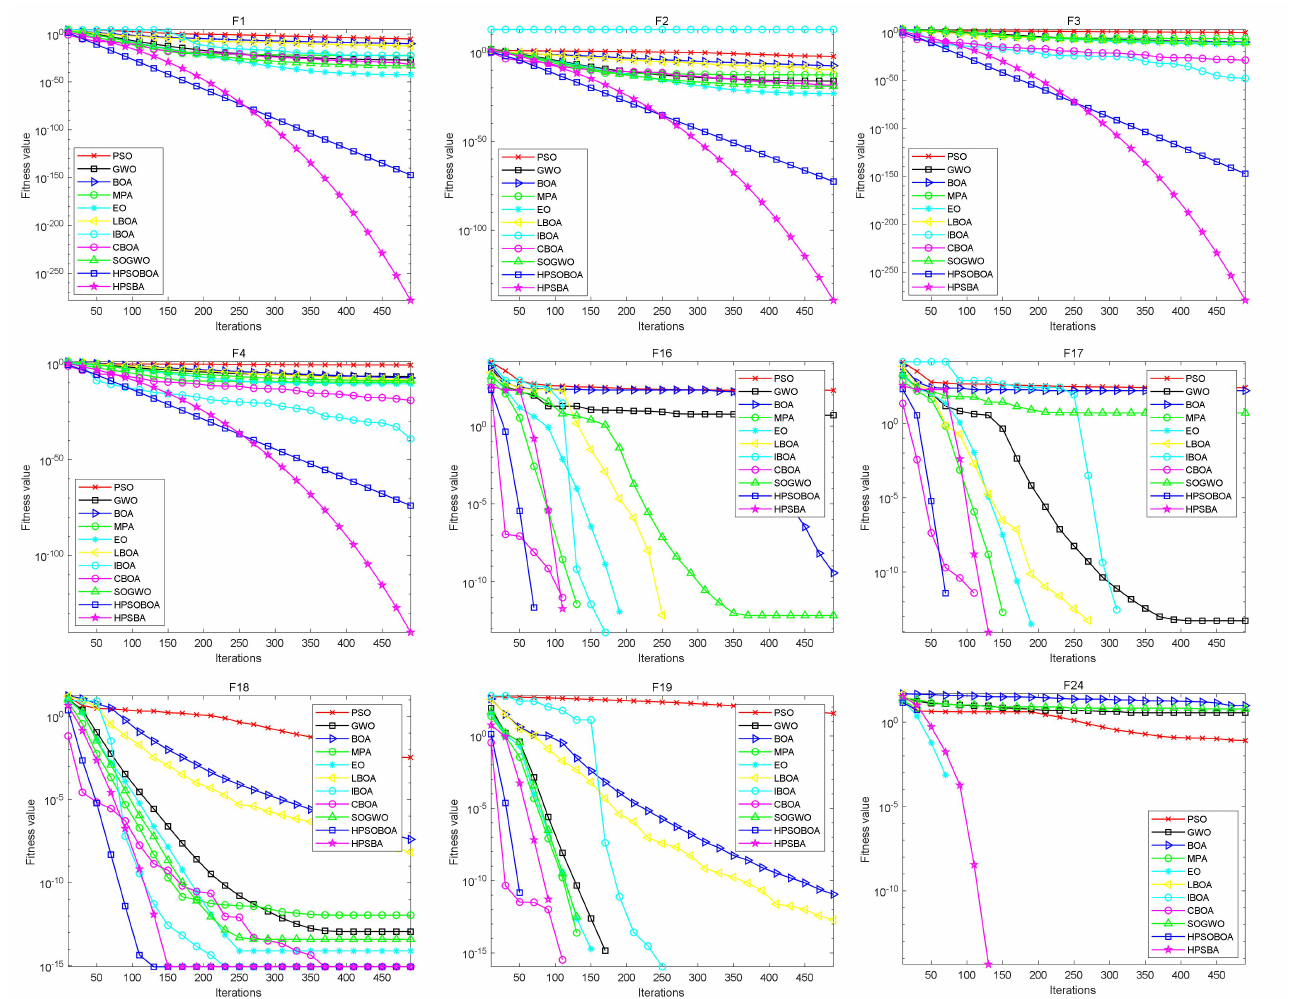
Figure 8. Convergence curves of comparison algorithms when Dim =